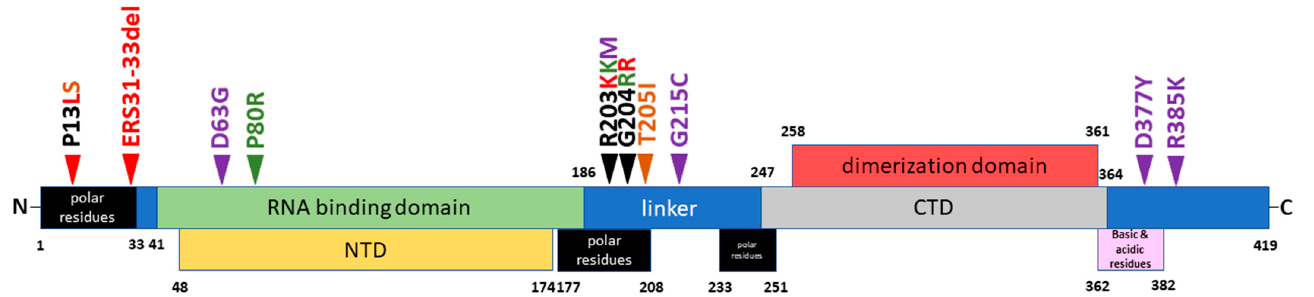
Figure 3. Scheme of N-protein domains and variable amino acid residues characterizing five different variants of the SARS-CoV-2 virus used in this work. The locations of the functional domains of the N protein are given according to [9]. The substitutions present in the N-protein sequences of the B.1.351 (brown), P.1 (green), B.1.617.2 (magenta) and B.1.1.529 (red) strains are indicated with arrows.